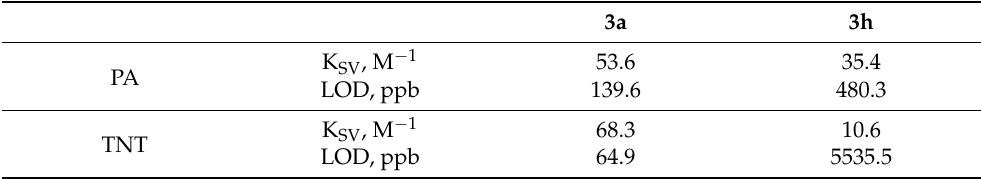
Table 4. Stern–Volmer constants and LOD for the 3a and 3h